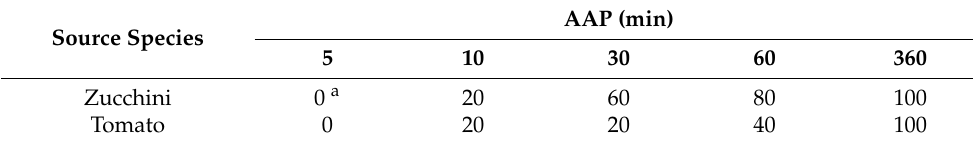
Table 3. Acquisition access period of the transmission of ToLCNDV-ES by B. tabaci . Source Species